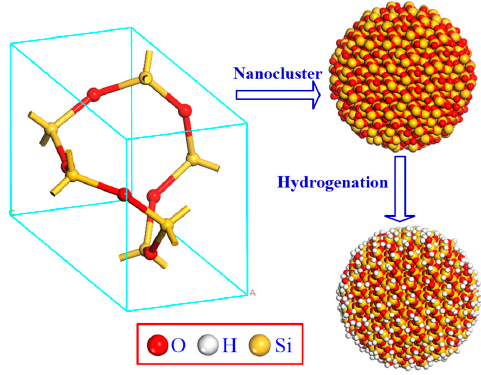
Figure 1. The model for the molecular structure of nano-SiO 2 particle clusters.